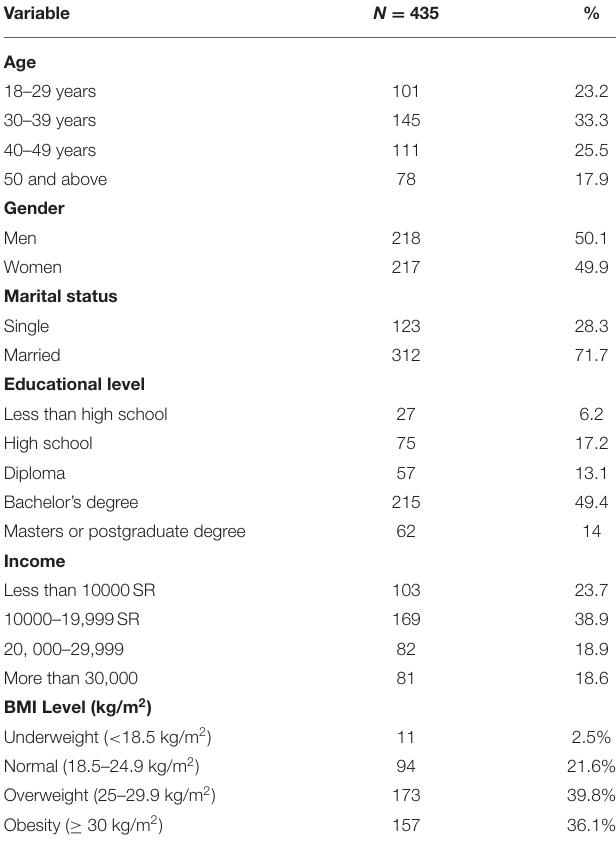
TABLE 1 | Demographic characteristic of the